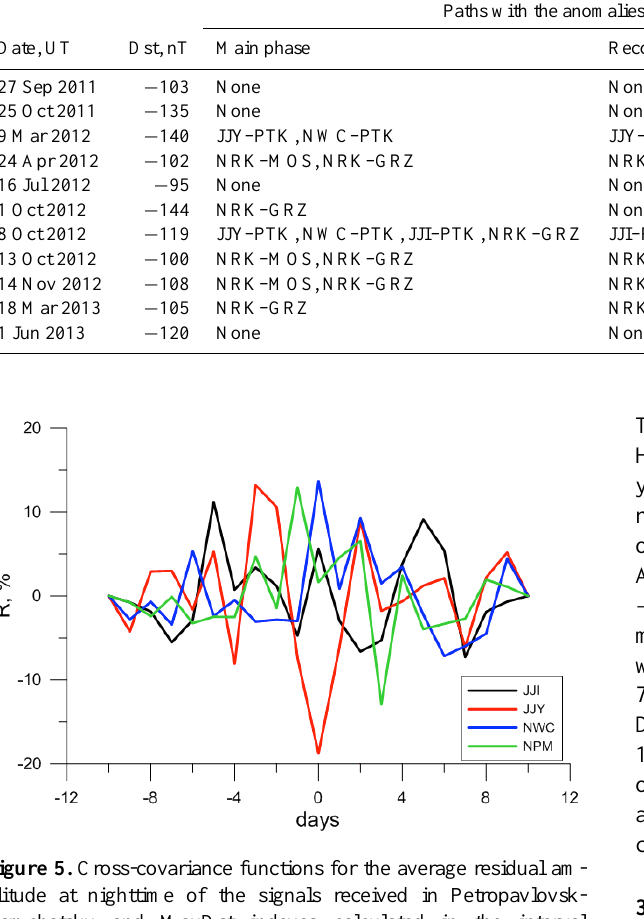
Table 1. Presence of anomalies in the VLF–LF signals during magnetic storms. Paths with the anomalies in the signal